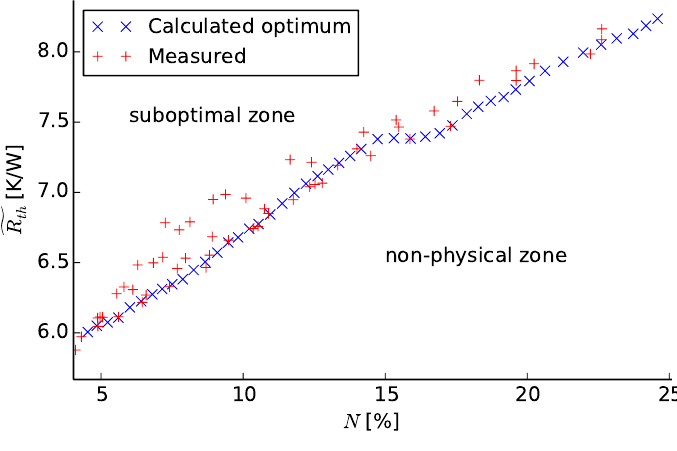
Figure 8. Measured thermal resistance and estimated thermal resistance at optimal